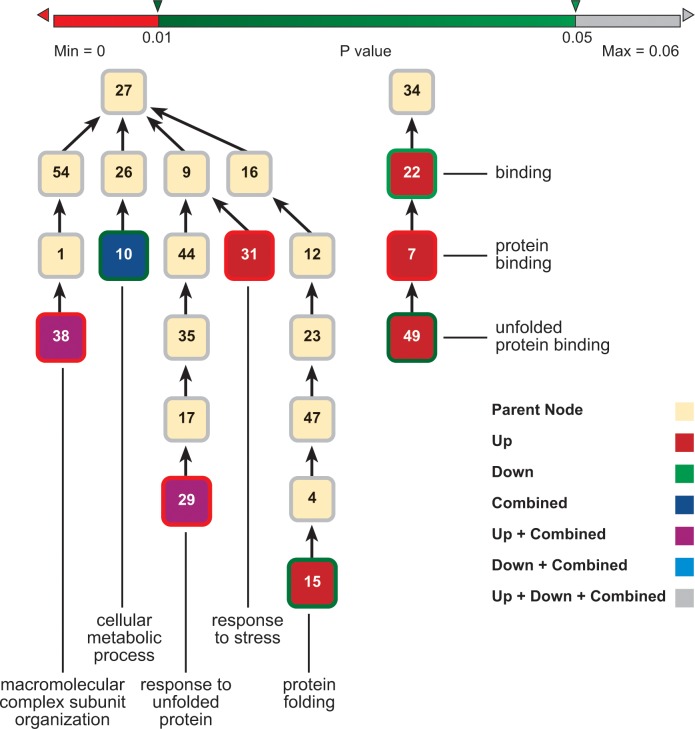
GO Biological Process and Molecular Function Trees (Benjamini-corrected p-value cutoff = 0.05) for the “Eutheria-conserved” Alarm_Pheromone Genes” Human Orthologs.This figure shows the Biological Process (left) and Molecular Function (right) Trees. “Eutheria-conserved” means that genes have orthologs in all eutherian species included in InParanoid database. Nodes with red bounds are GO terms with p-value (Benjamini p-value) < = 0.01. Nodes with various green bounds are nodes with p-value between 0.01 and 0.05. Nodes with white bounds (or no bounds as it is the same as the background color) are not themselves enriched but are parents of enriched terms in the GO hierarchy. Enriched nodes are labeled with the names of the GO term. All nodes are numerically tagged. The correlations between the numerical tags and the names of the GO categories is given in Table 3. Separate GO analysis are done for all the up-regulated “Eutheria-conserved” Alarm_Pheromone Genes” Human orthologs (Up”), all the down-regulated orthologs (“Down”), and all regardless of regulation (“Combined”). The results are indicated by the colors of the node faces as follows: GO category enriched in the up-regulated subset only is red; GO category enriched in the down-regulated subset only is green; GO category enriched in the complete set is deep blue; GO category enriched in the up-regulated subset and the complete set is purple; GO category enriched in the down-regulated subset and the complete set is light blue; GO category enriched in both subsets and in the total set is gray. For example, a Biological Process GO term indexed “29” and identified as “response to unfolded protein” is seen as significant in the analysis for up-regulated and for all genes (Hence it is in purple, the,”Down+Combined” color, and bordered in red because the p-value was below 0.01). All the names for the enriched GO terms and their parents are in Table 3 (The tables and this tree are designed to be complementary to each other. The trees show the overall architecture of the relationships among GO categories while the tables provide more detail) and in S2 Table. Corresponding information in spreadsheet form is provided for the “Mouse-and-human conserved” and “All-Vertebrate-Conserved” sets in S2 Table.